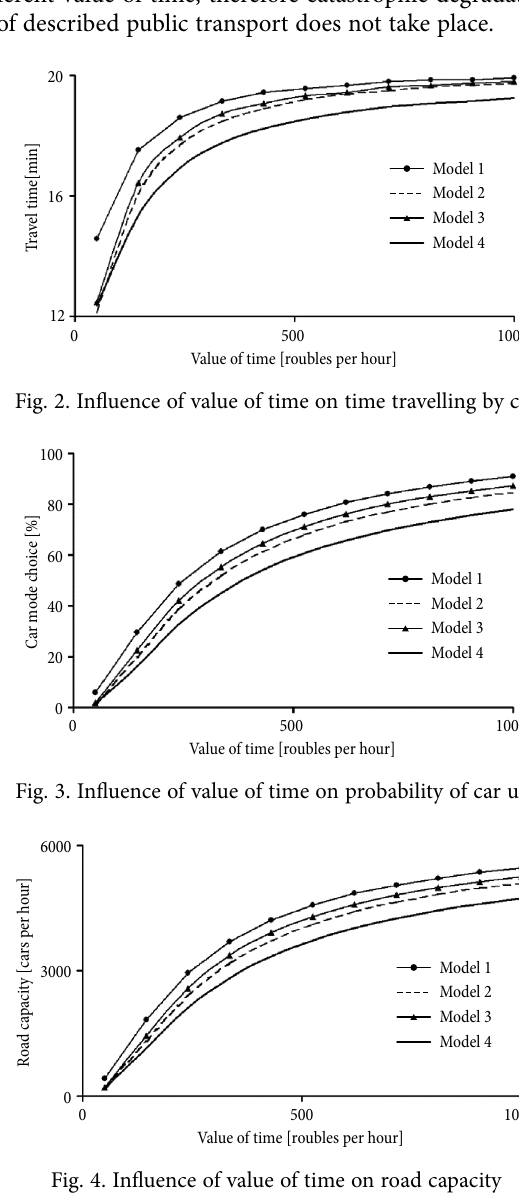
Fig. 5. Influence of value of time on public transport frequency